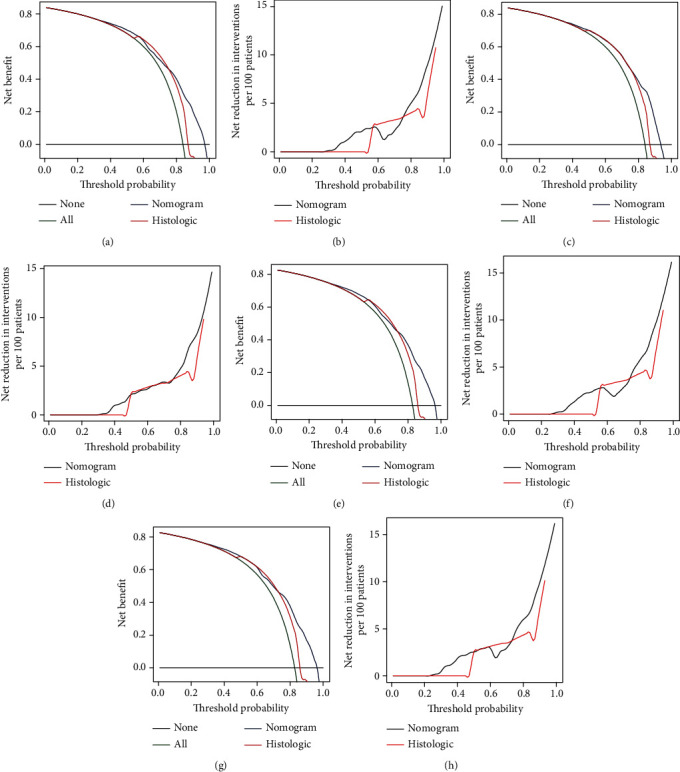
Decision curve analysis for the nomograms and histologic type of validation set. Figure (a) and (c) are the new benefit curves of 3- and 5-year OS rates of validation set. Figures (b) and (d) are the net reduction for intervention curves of the 3- and 5-year OS rates of the validation set. Figure (e) and (g) are the new benefit curves of 3- and 5-year CSS rates of validation set. Figures (f) and (h) are the net reduction for intervention curves of the 3- and 5-year CSS rates of the validation set.